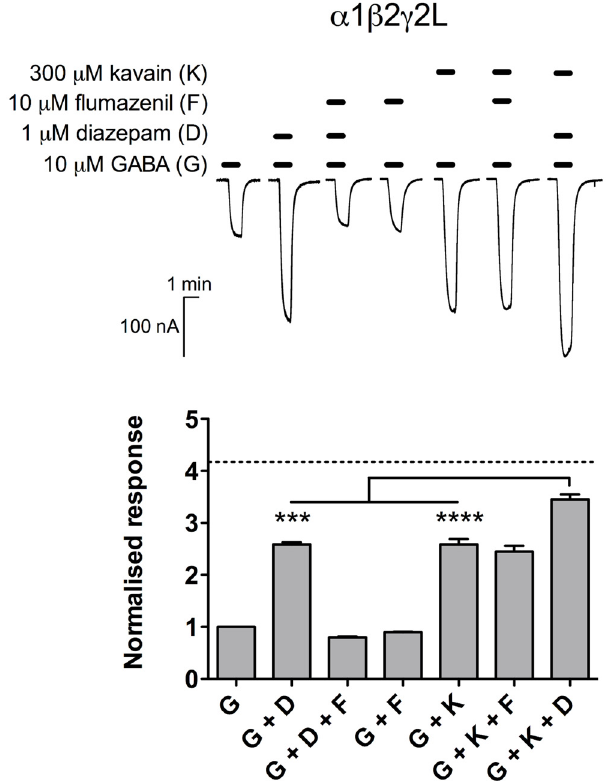
Fig 4. Flumazenil-insensitive kavain potentiation has less-than-additive effect on diazepam action. Top , Representative traces demonstrating responses to control (10 μ M GABA); control and 1 μ M diazepam; control, 1 μ M diazepam and 10 μ M flumazenil; control and 10 μ M flumazenil; control and 300 μ M kavain; control, 300 μ M kavain and 10 μ M flumazenil; and control, 300 μ M kavain and 1 μ M diazepam. Bottom , The modulatory effect of diazepam, flumazenil and kavain at α 1 β 2 γ 2L GABA A Rs ( n = 5). Kavain potentiation was unchanged in the presence of flumazenil (G + K vs . G + K + F; p > 0.05; paired t test). The combination of kavain and diazepam (G + K + D) resulted in greater potentiation than diazepam (G + D; p < 0.001; paired t test) and kavain (G + K; p < 0.0001; paired t test) alone, but the effect was less than the expected additive modulatory effect (dotted line). Data are normalised to the current responses elicited by 10 μ M GABA, and are presented as mean ±